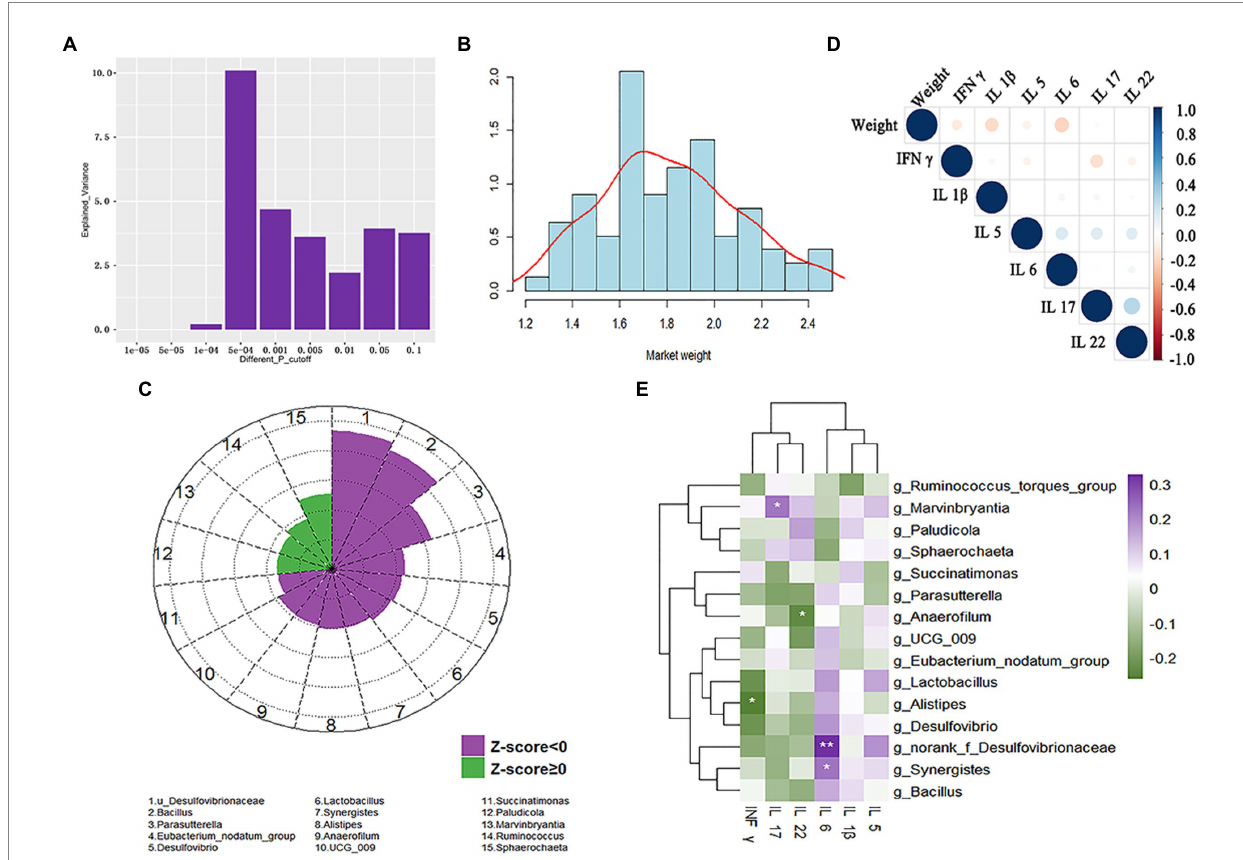
FIGURE 8 Correlation of market-weight (body-weight at 160 ± 3 days of age) with cecal microbiota and serum inflammatory cytokines in the validation cohort composed of 24 Wumeng black-bone chickens and 55 Guizhou yellow chickens. (A) Variation of market-weight explained by cecal microbiota under different significant thresholds. (B) Inter-individual variation in market-weight. (C) Cecal microbiota significantly associated with chicken market- weight. Associations between cecal microbiota and market-weight are shown as Z scores. Z < 0 and Z ≥ 0 indicates a negative association and a positive association, respectively. (D) Correlation between market-weight and 6 inflammatory cytokines. (E) Correlations between the abundance of cecal microbiota and host inflammatory cytokines quantified by Spearman correlation with Benjamini–Hochberg corrections. * p < 0.05, ** p < 0.01, *** p <